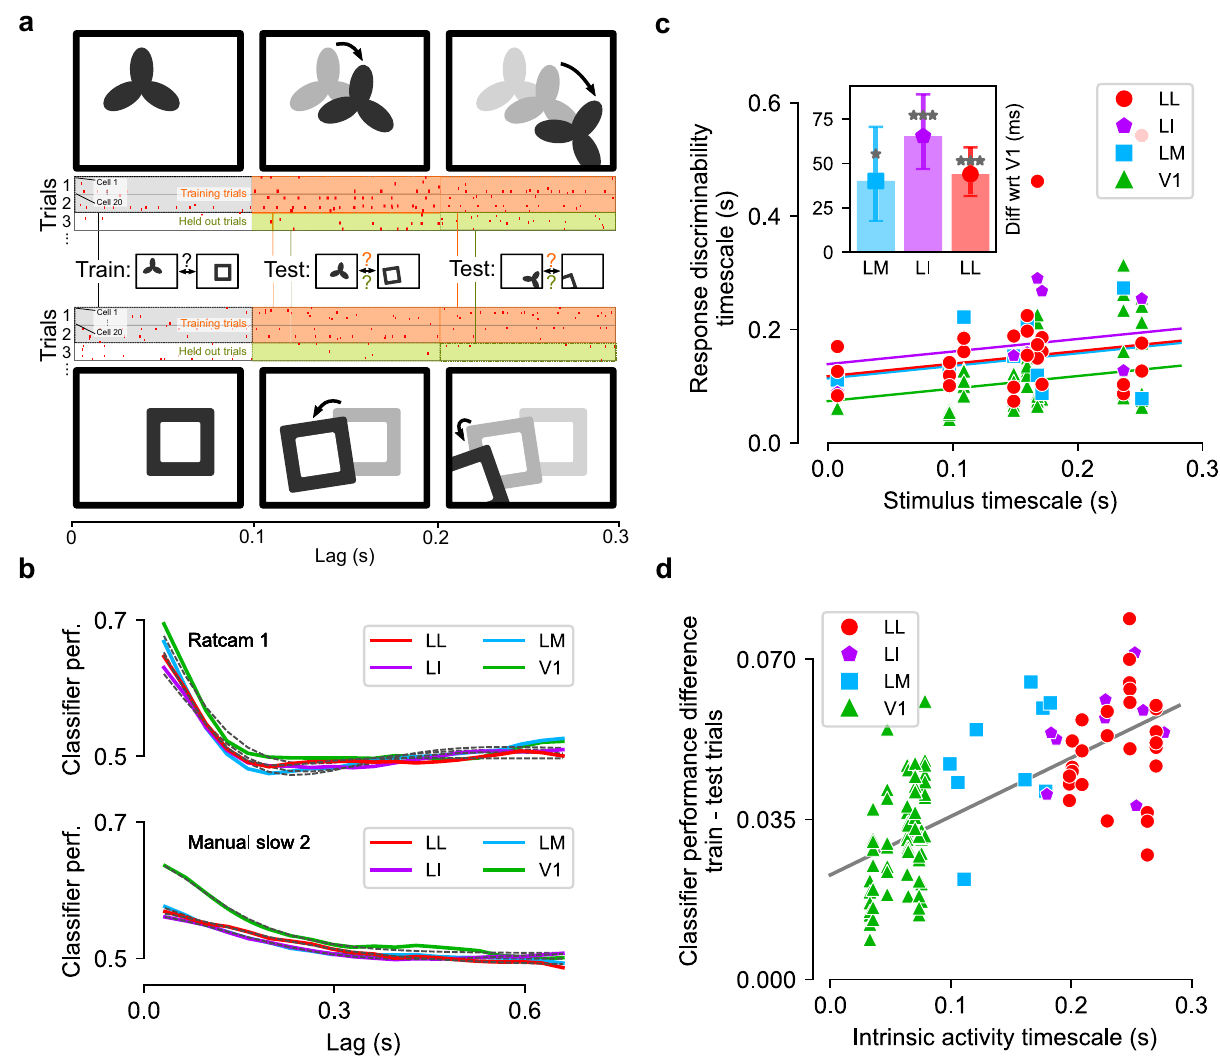
Fig. 5 Temporal stability of neuronal representations, as assessed through decoding analysis. a Schematic of the classi fi er analysis, aimed at assessing the temporal stability of the population representation. A linear classi fi er is trained to distinguish the population activity recorded at two different time points of the movie (spike counts computed from the gray time bins) and tested at other time points that follow (or precede, not shown) the training points by a certain lag. The classi fi er is tested on a held-out set of trials (green boxes), as well as on the same experimental trials that were used for training (orange boxes). The cartoons of the movie frames shown on top or below each time bin are for illustration purpose only: they highlight the fact that, in general, two nonoverlapping segments of a movie (from which the population activity is decoded) will contain different, transforming (e.g., translating, rotating, etc.) objects. For clarity, in this illustration, the size of the spike-count windows (i.e., gray, orange, and green boxes) was set to 100 ms, while 33- ms wide bins were used in the actual analysis. The spike patterns shown in the cartoon correspond to those actually fi red by a randomly selected pseudopopulation of 20 units in V1 at two time points during the presentation of one of the movies (only three trials shown out of 30). b Classi fi er performance on held-out trials for two example movie stimuli and one example pseudopopulation per area (colored curves). The performance is plotted as a function of the lag between training bin (gray boxes in a ) and test bin (green boxes in a ), and is fi tted with either an exponential decay or a damped oscillation function ( fi ts are shown as black dashed lines). c Timescale of response discriminability, measured as the time constant of the exponential decay of the classi fi er performance on the held-out trial set, as a function of the timescale of the movies. Each dot corresponds to a distinct pseudopopulation of 20 units. The solid lines are linear regressions with common slope and different intercept across the four areas. The inset shows the difference of the intercept for areas LM, LI, and LL vs. area V1 (error bars are standard errors of the differences in the linear regression analysis). N = 36 independent combinations of movies and areas (* p = 0.03, *** p < 1e − 4 for LI, p = 2e − 4 for LL, one-tailed bootstrap test, 10 4 bootstrap samples, no multiple test correction). d Amount of classi fi er performance due to intrinsic correlations ( Δ p , Eq. (1)) as a function of the timescale of such correlations (i.e., the intrinsic timescale of neuronal activity shown in Fig. 4d). Source data are provided as Source Data fi activity vectors used in training and testing. This analysis was above for the temporal correlations of neural responses (black repeated for each population and movie, and for all possible dashed lines). Linear regression revealed that the decoder ’ s choices of pairs of training time points (see “ Methods ” ). The performance depended signi fi cantly on the timescale of the movie results were averaged over these pairs to measure mean stimulus (Fig. 5c; common slope: 0.22, 68% CI [0.15 – 0.32], discrimination performance as a function of the lag (Fig. 5b; nonzero at p = 8e − 4, one-tailed bootstrap test). In addition, the colored lines), and then fi t with the same functional form as intercept of the fi t was signi fi cantly larger in the three extrastriate